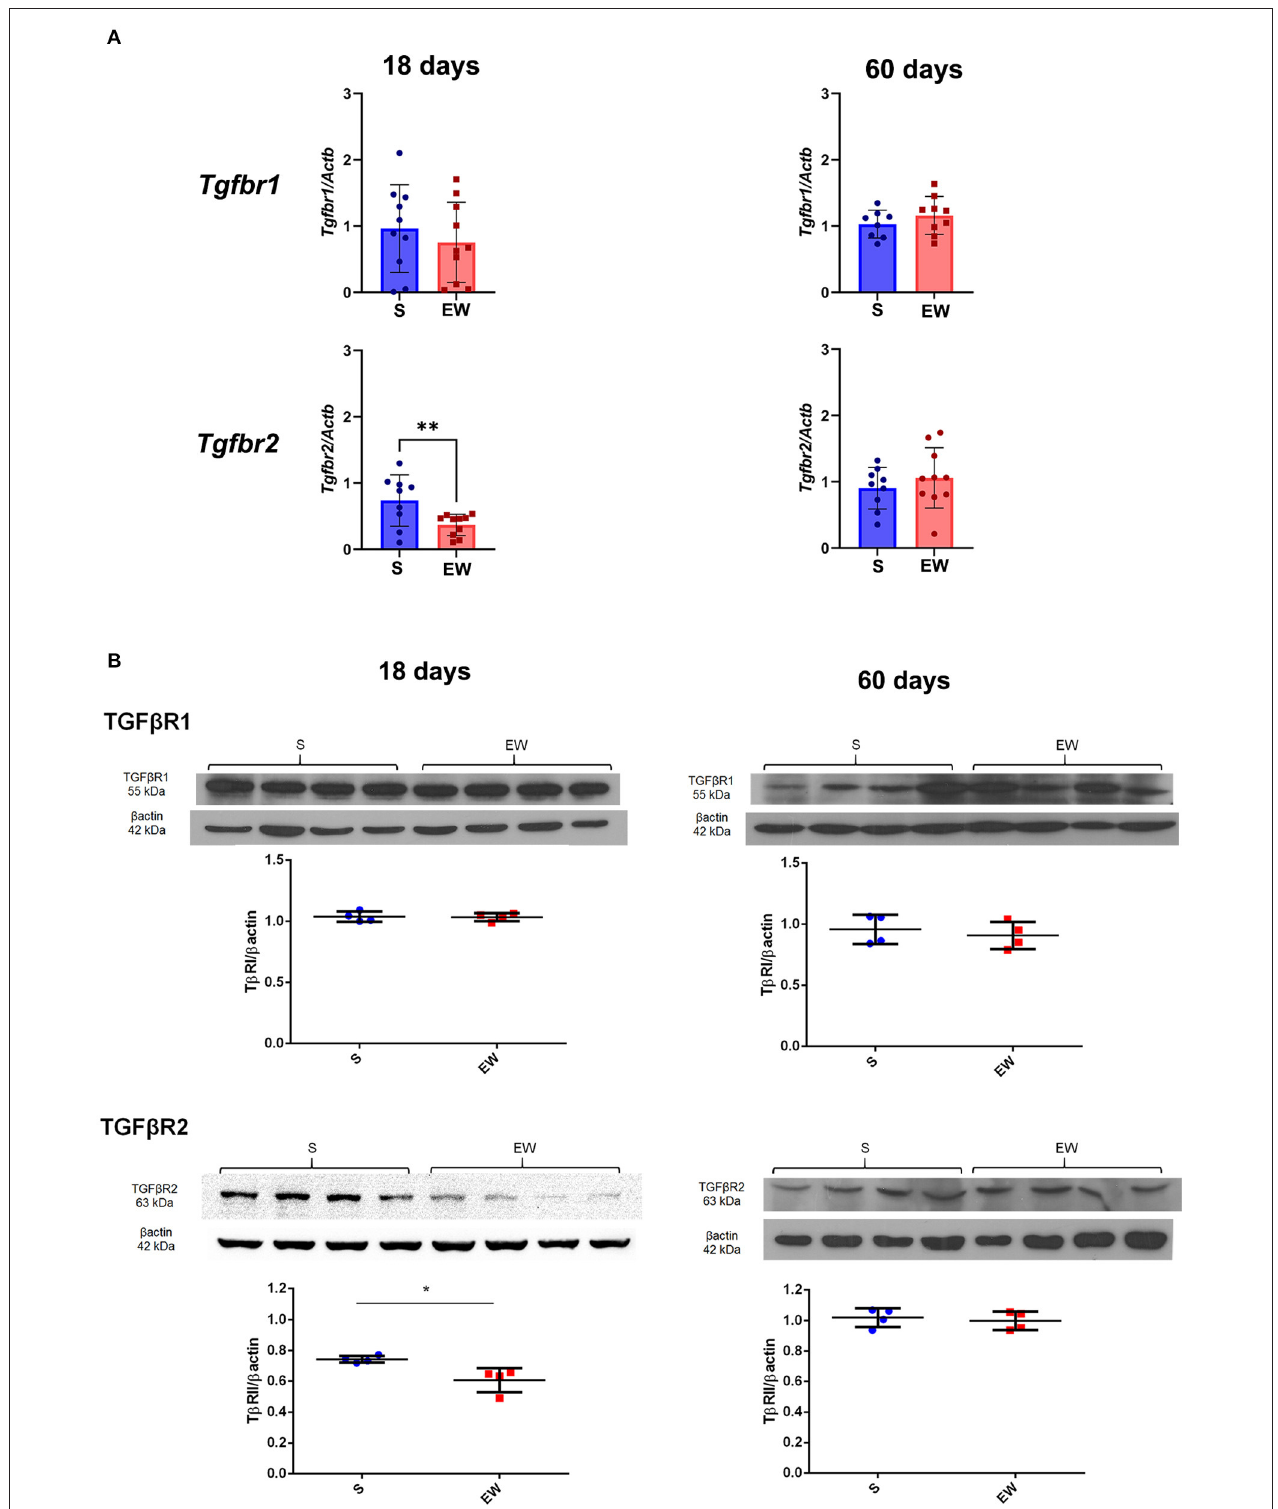
FIGURE 5 | Differential effects of early weaning on gene expression and protein levels of the TGF beta receptors. (A) Tgfbr1 and Tgfbr2 expressions in S (blue) and EW (red) groups at 18 and 60 days after RT-qPCR. (B) Representative immunoblots for TGF β R1 and TGF β R2 and respective β -actin loads (four samples/group). Densitometry was used to compare the integrated optical density (IOD) of each receptor in each sample to β -actin control. Results are represented individually for S (blue) and EW (red) and by means ± SD * p < 0.05 and ** p < 0.01 after Student’s t -test.